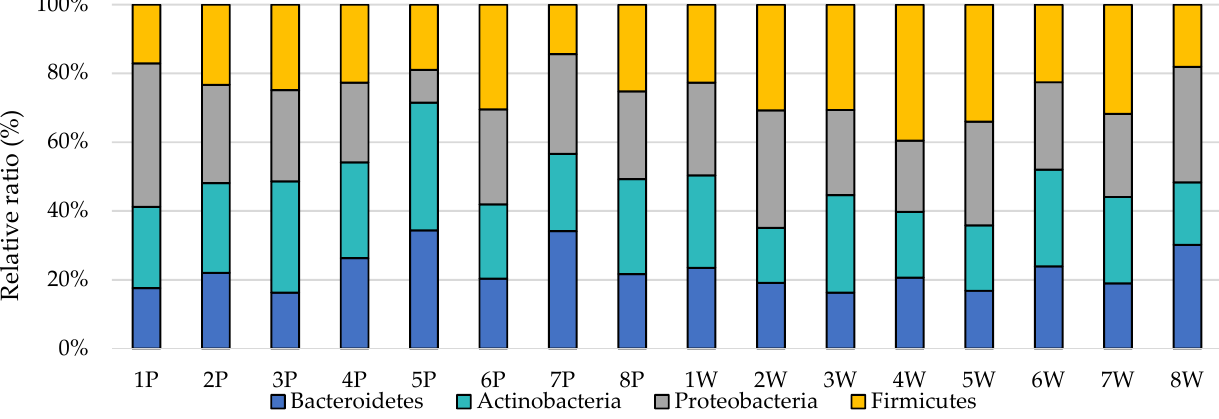
Figure 2. Relative ratio (%) of the chosen bacteria phyla in individual animals (P—primiparous, W—multiparous).